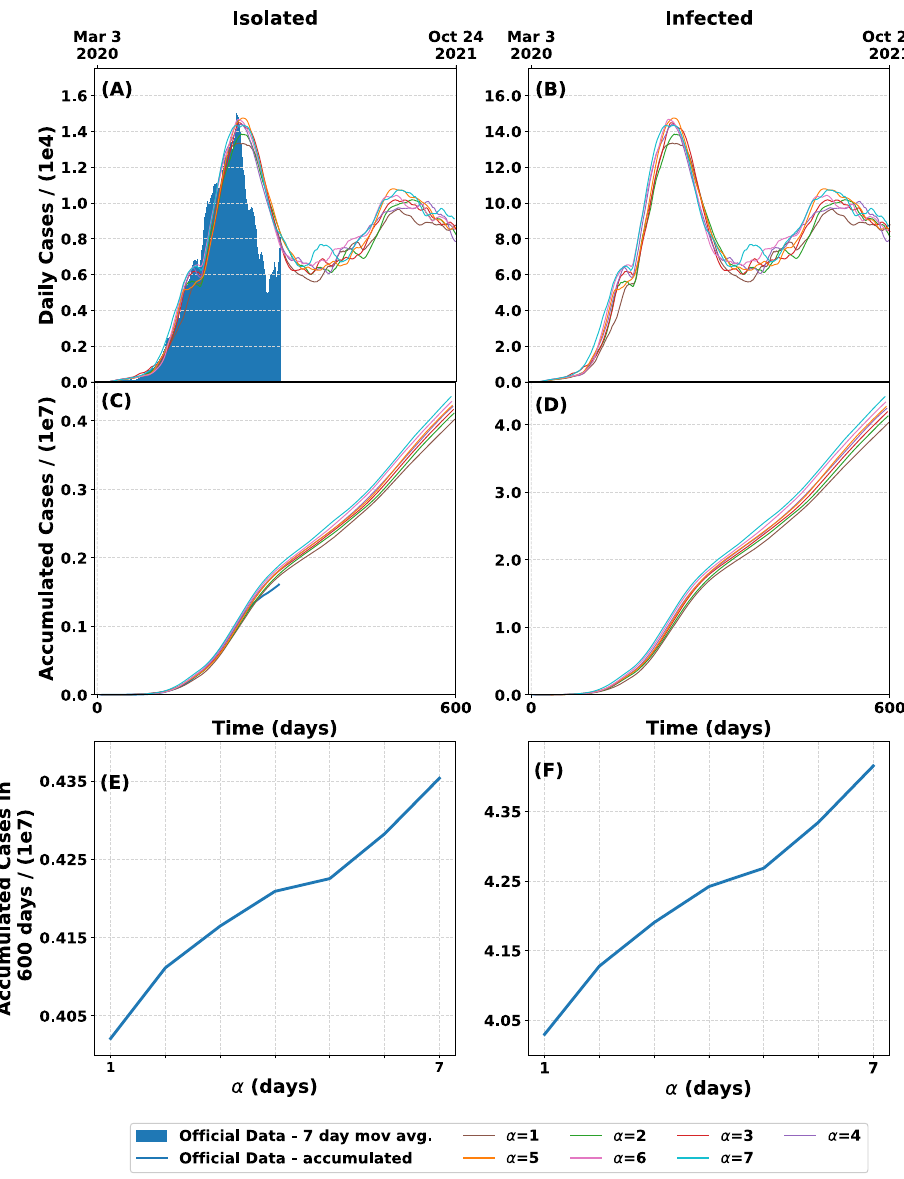
Figure 4. Model prediction according to different values of the parameter α , the period of time between infection and isolation. For each curve we did 100 runs of the model. The value p is fixed to 0.1 and the mobility is the one fitted for α = 5 . ( A ) Daily discovered (isolated) cases for different values of α . ( B ) Daily actually infected cases for different values of α . ( C ) Accumulated discovered (isolated) cases as function of time. The blue curve represents the temporal evolution of the actual accumulated cases obtained from official data. ( D ) Accumulated infected cases as function of time. ( E ) Accumulated isolated cases after 600 days as a function of α . ( F ) Accumulated infected cases after 600 days as a function of α . The longer the time to discover and isolate new infected cases, the greater the number of patients expected and, therefore, the greater the number of isolated